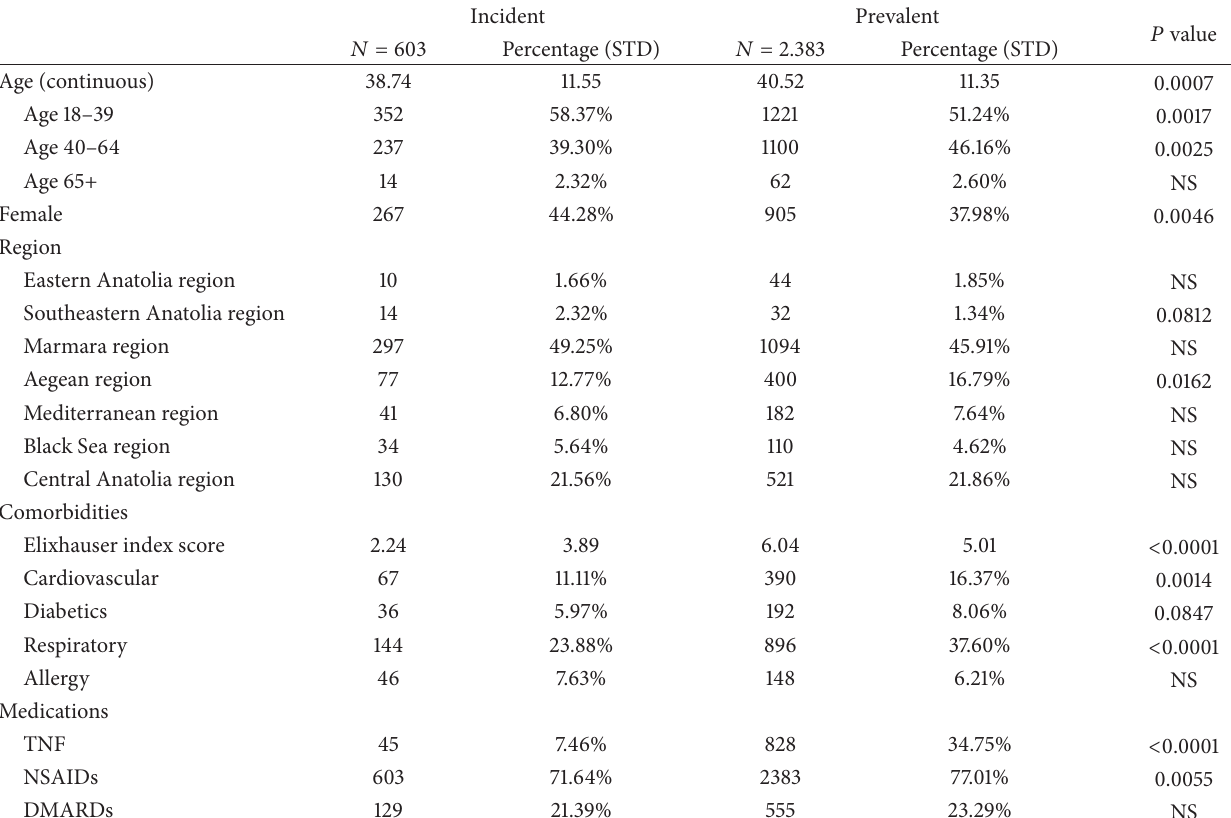
Table 1: Demographic and clinical characteristics of patients with incident and prevalent ankylosing spondylitis.